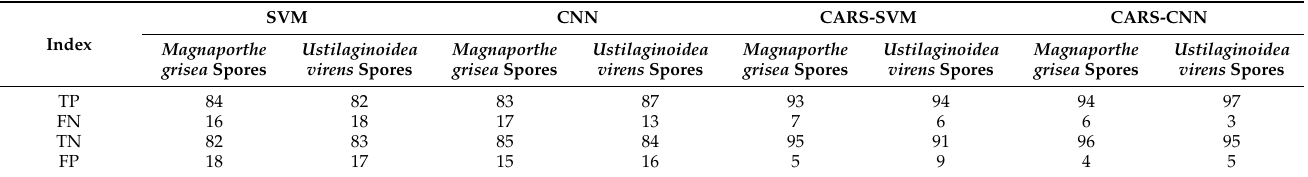
Table 2. Classification results of different models.